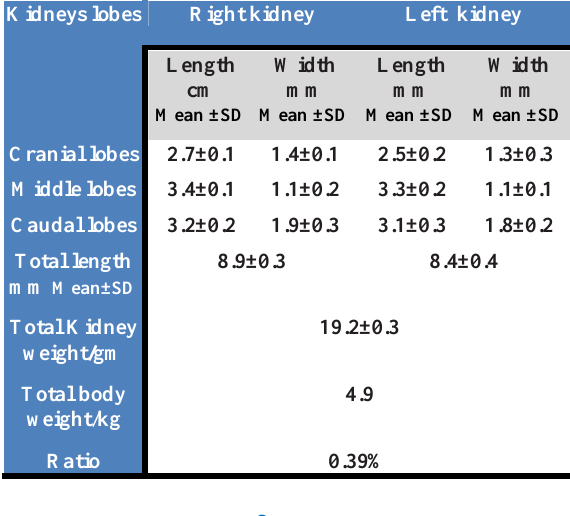
Table, 1: The length, width of flamingo's kidney lobes, total length of kidney, total kidney weight, total body weight and the ratio.